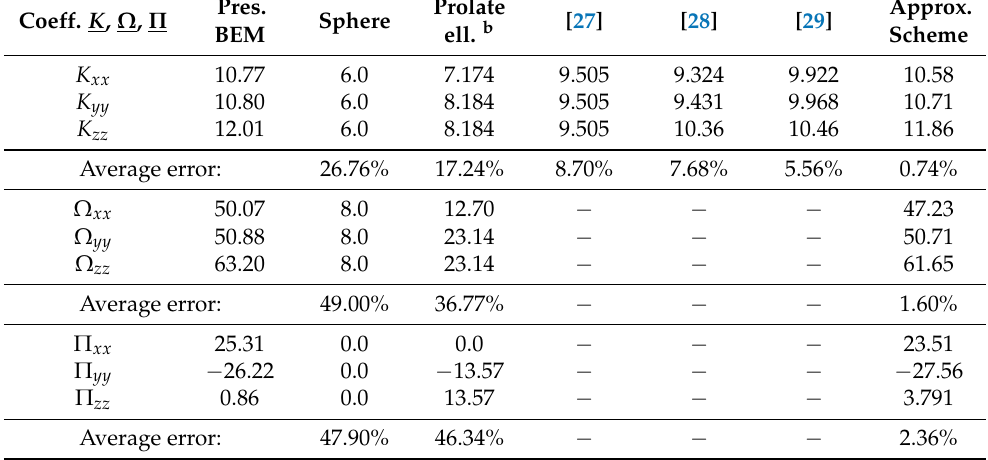
Table 5. K , Ω and Π tensor coefficients are determined for an example of the pollen grain. First the present BEM code result is presented, obtained for the actual reconstructed particle geometry, as illustrated in Figure 10b. This is followed by the results obtained analytically with two simplified particle representations, namely the sphere and the prolate (considering λ 1 of the particle). After that, the empirical models from Haider and Levenspiel [27], Leith [28] and Holzer and Sommerfeld [29] follow (applies only for the K tensor components). In the last column, the result of the approximation scheme is shown, for the superellipsoid ( λ 1 = 1.96, λ 2 = 1.83, e 1 = 0.564, e 2 = 0.472 ) , that best matches the pollen grain. Coeff. K , Ω , Π